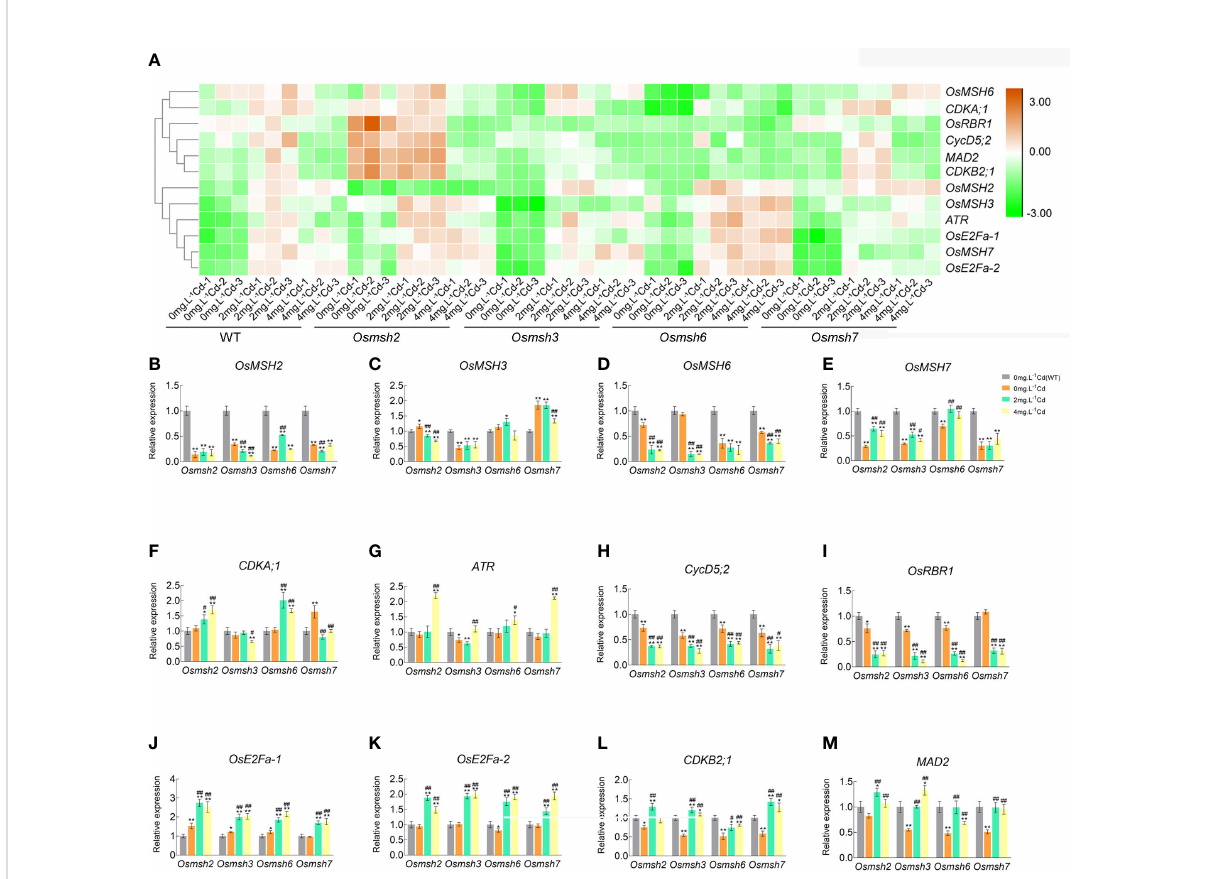
FIGURE 4 Differential expression pro fi les and quantitative validation of cell cycle-related genes in response to Cd stress in rice Osmsh2 , Osmsh3 , Osmsh6 and Osmsh7 mutant leaves. (A) Heat map representing some of the 12 cell cycle-related DEGs (P-adj ≤ 0.05 and log2-fold change ≥ 1.5). Each row shows the relative expression levels of individual genes and each column shows the expression levels of individual samples. (B – M) The expression levels of the WT were set to 100% in the control by qRT-PCR analysis. Data were shown mean ± SD at least three independent experiments, and house-keeping gene Osactin was used as an internal control. * and # signi fi cantly statistical difference from the WT control and the corresponding mutant control, respectively (P < 0.05). ** and ## were signi fi cantly different from WT control and WT mutant control (P <